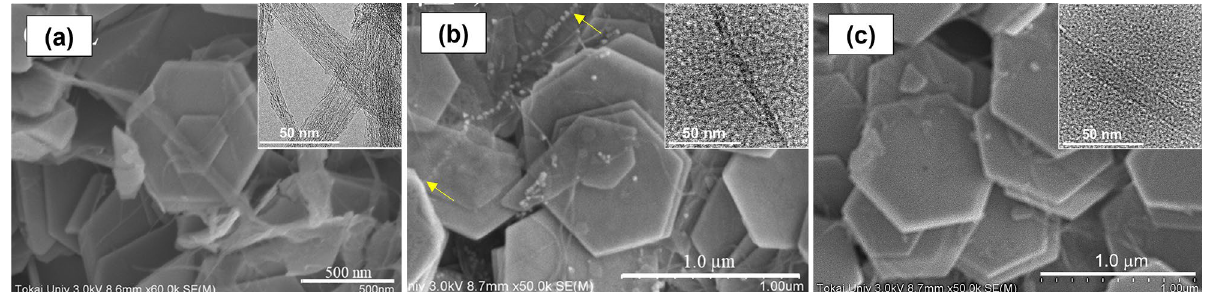
Figure 4. SEM image of nanocomposite films based on Bi 2 Te 3 nanoplates and different SWCNTs. The insets show the HRTEM images of each SWCNT. ( a ) Pristine SWCNTs, ( b ) SWCNTs in the top solution, and ( c ) SWCNTs in the bottom